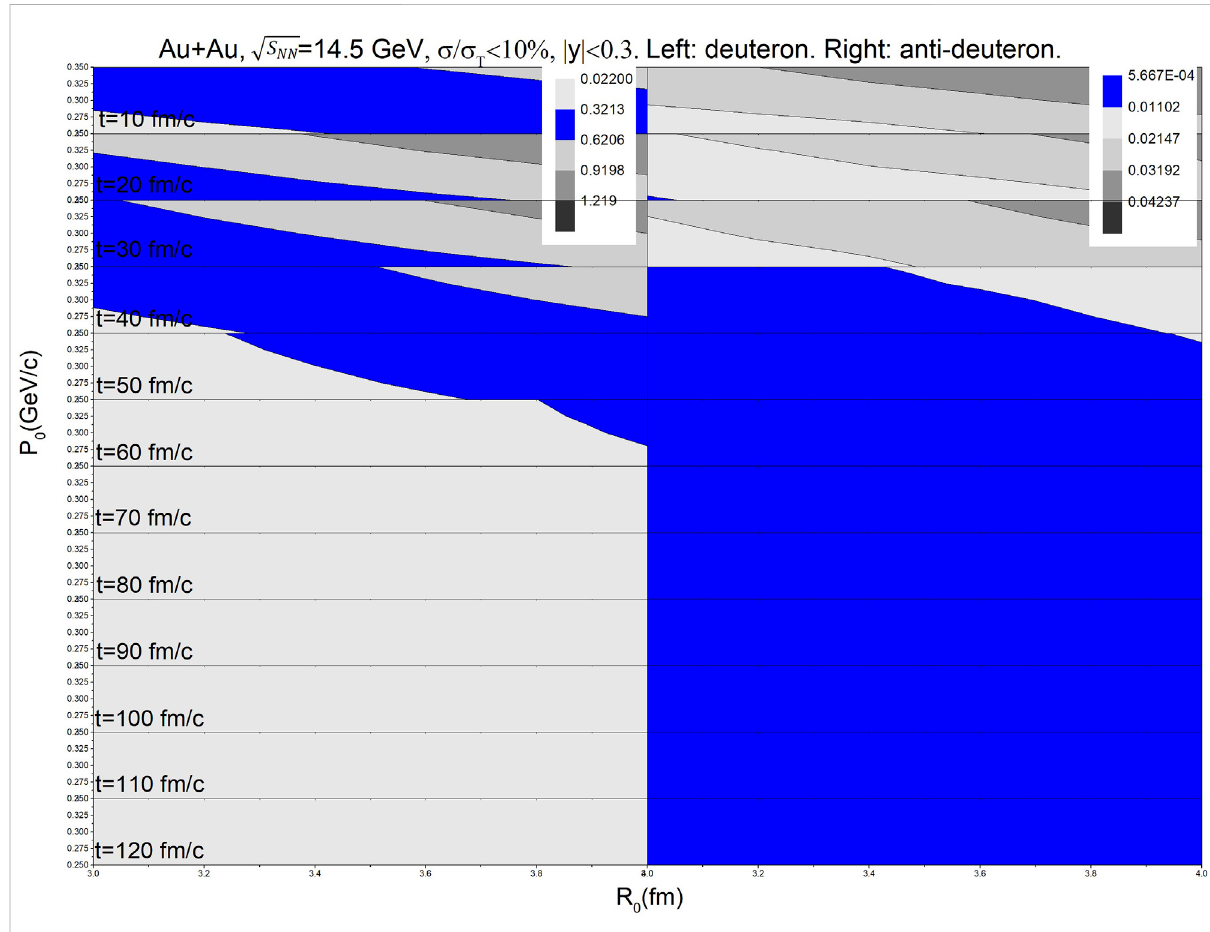
√ (cid:1)(cid:1)(cid:1)(cid:1) s NN = 14.5 GeV. The blue areas represent the